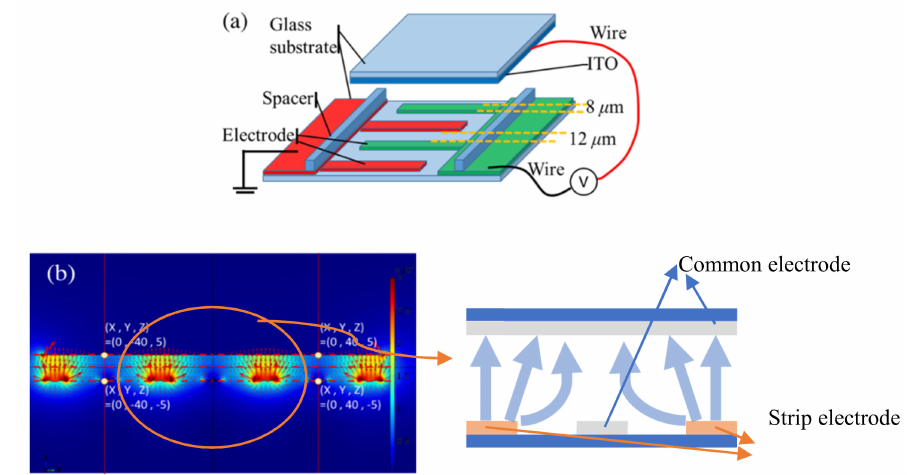
Figure 1. ( a ) The cell structure and the way to apply a voltage to the cell. The top substrate is covered by the transparent conductive film (ITO film) without any pattern. ( b ) The simulated distribution of the electric field of the 10- µ m tilted-field-switching (TFS) cell. The spacing between two strip electrodes is 32 µ m and the spacing between the strip and common electrodes is 12 µ m. The width of the common electrode is 8 µ